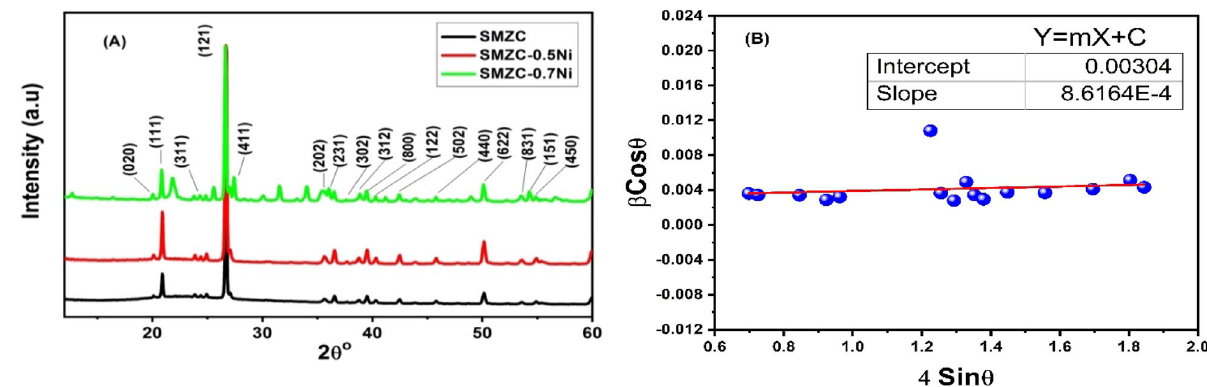
Figure 2. ( A ) XRD spectra of the SMZC/(0, 0.3, 0.5, 0.7) Ni 2+ , calcined at 800 °C, and ( B ) a plot of Williamson- Hall relation of SMZC